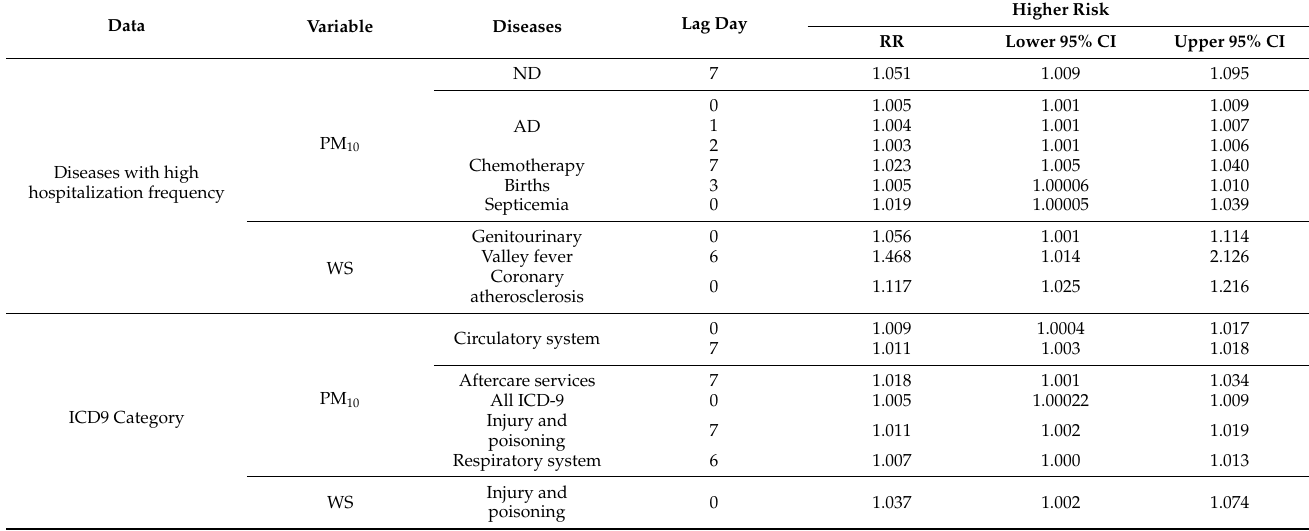
Table 3. Significant associations between the diseases and DE-related variables, and the corresponding relative risk